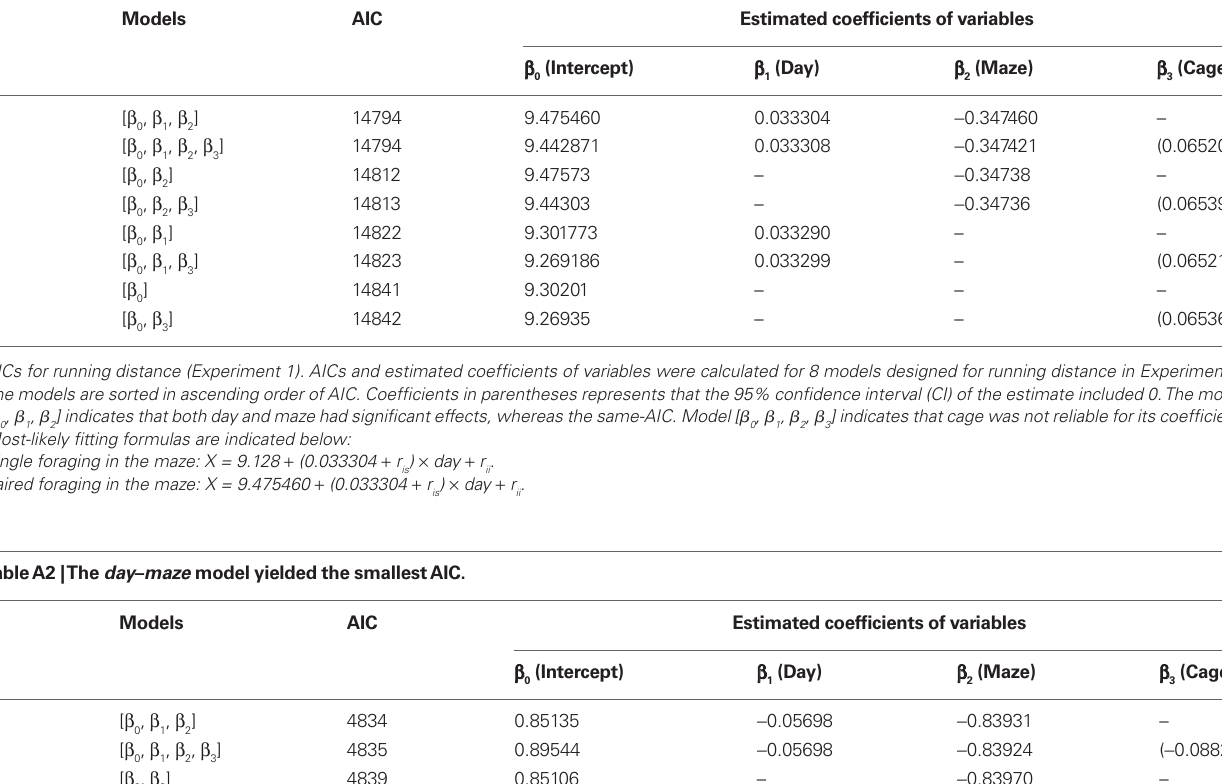
Table A1 | The day – maze model yielded the smallest AiC.